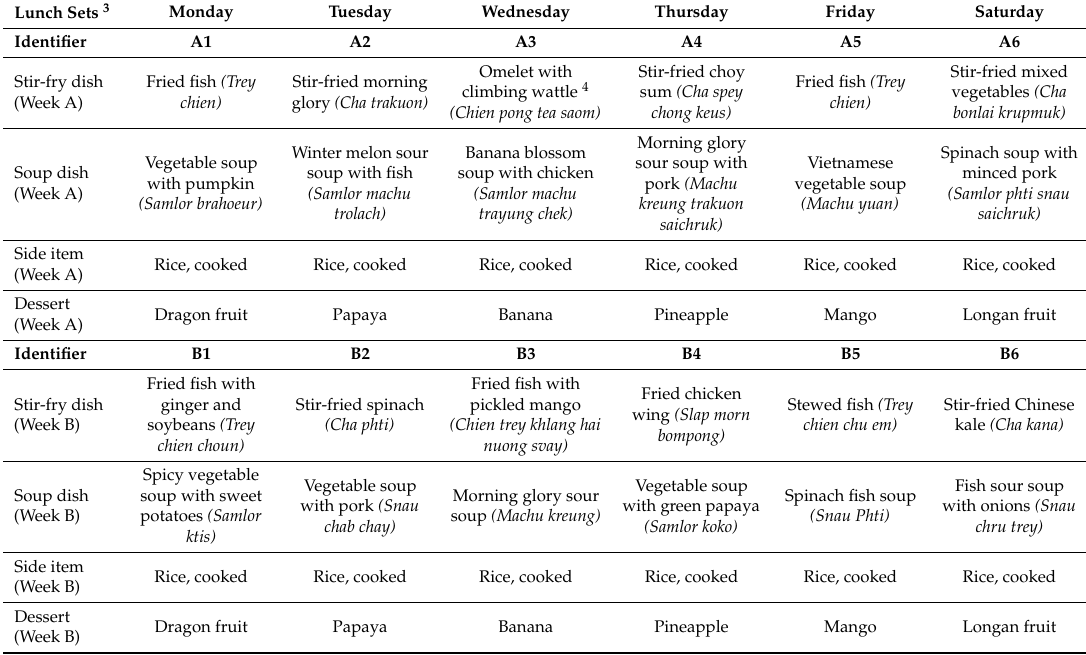
Table 2. Biweekly menu for lunch provision at a garment factory in Phnom Penh, Cambodia 1,2